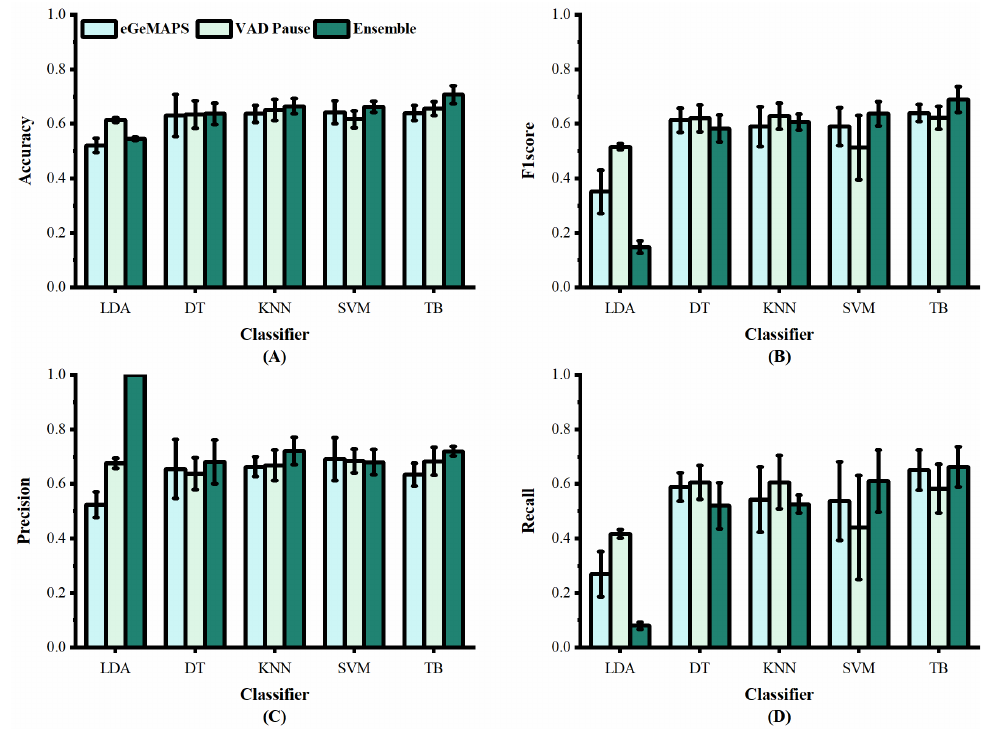
Figure 6. Performance of features from our study and [30] on dataset ADReSSo: ( A ) accuracy; ( B ) F1 score; ( C ) precision; ( D ) recall. Table 3. Accuracy (ACC) comparison of the ensemble method with other approaches, using only acoustic features on the test sets in the literature.